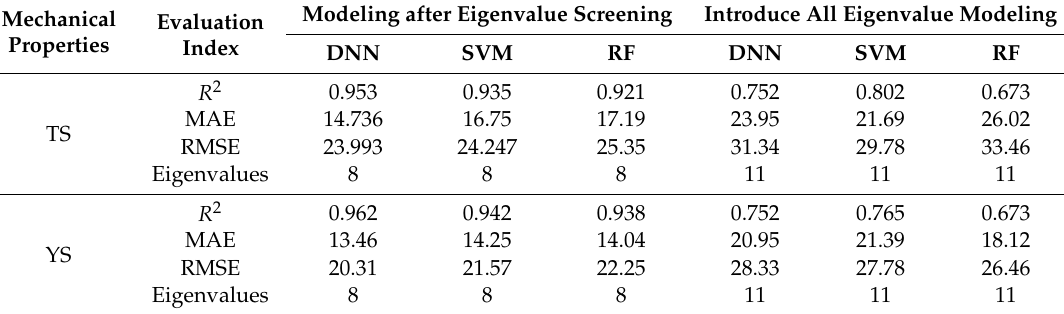
Table 3. Evaluation indexes of the mechanical prediction